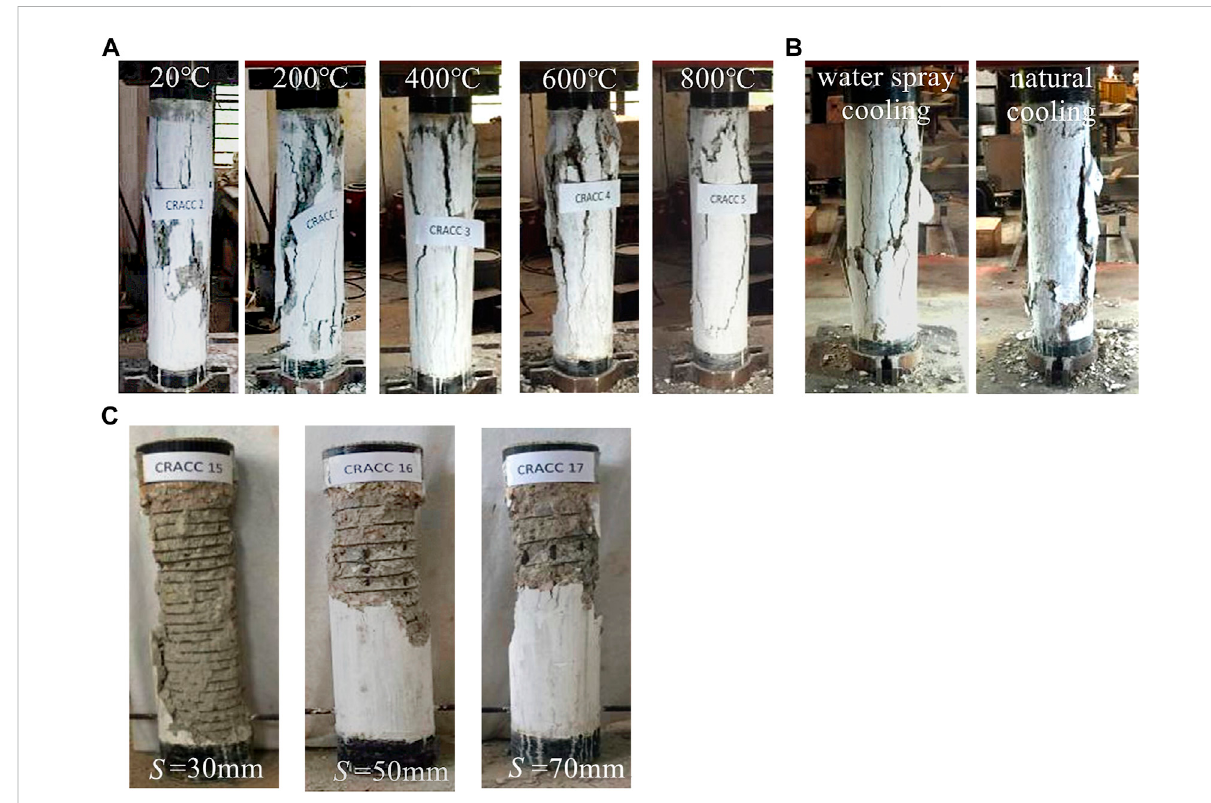
FIGURE 7 Finalfailuremodes. (A) Failuremodesofspecimensatdifferenttemperatures; (B) Failuremodesofspecimensunderdifferentcoolingmethods; (C) Failure modes of specimens with different spiral reinforcement